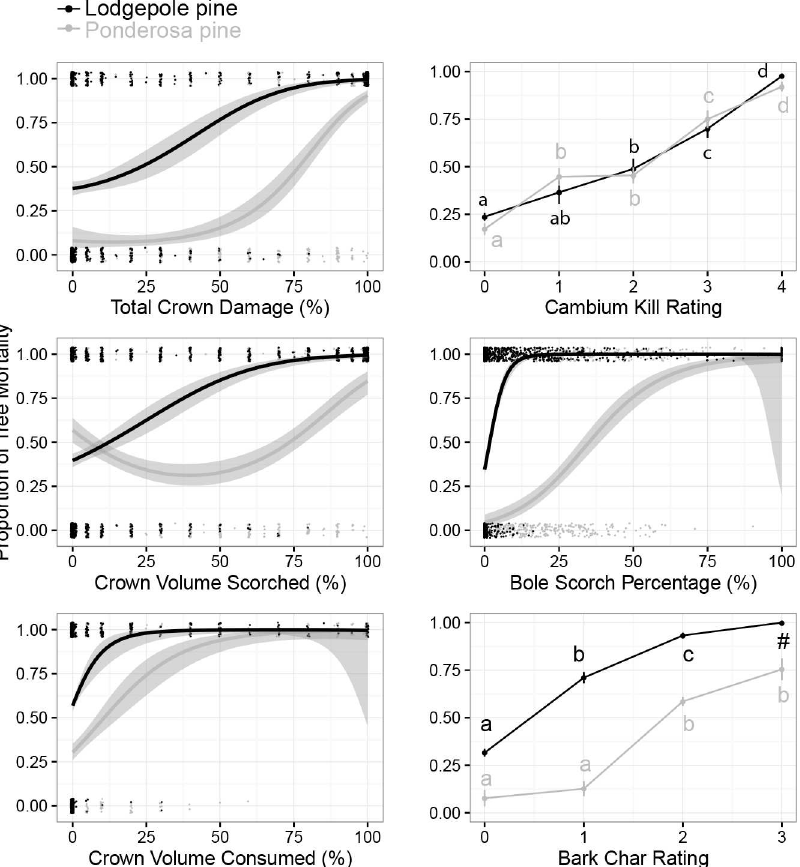
Fig 7. Relationships between fire injury measures and tree mortality. Generalized linear models representing the probability of mortality of lodgepoleand ponderosapines within 3 years post-fire for four continuous and two categorical measures of fire injury. Models for each continuousmeasure were alloweda polynomial term, althoughin some cases these terms were not significant. For categorical measures, different letters indicate significant differences ( α (cid:20) 0.05) among severities of fire injury categoriesfrom Tukey HSD pairwise comparisons. All data were modeled with a binomial distribution and all models were globallysignificant as measured with likelihoodratio tests. Model parametersin S4 and S5